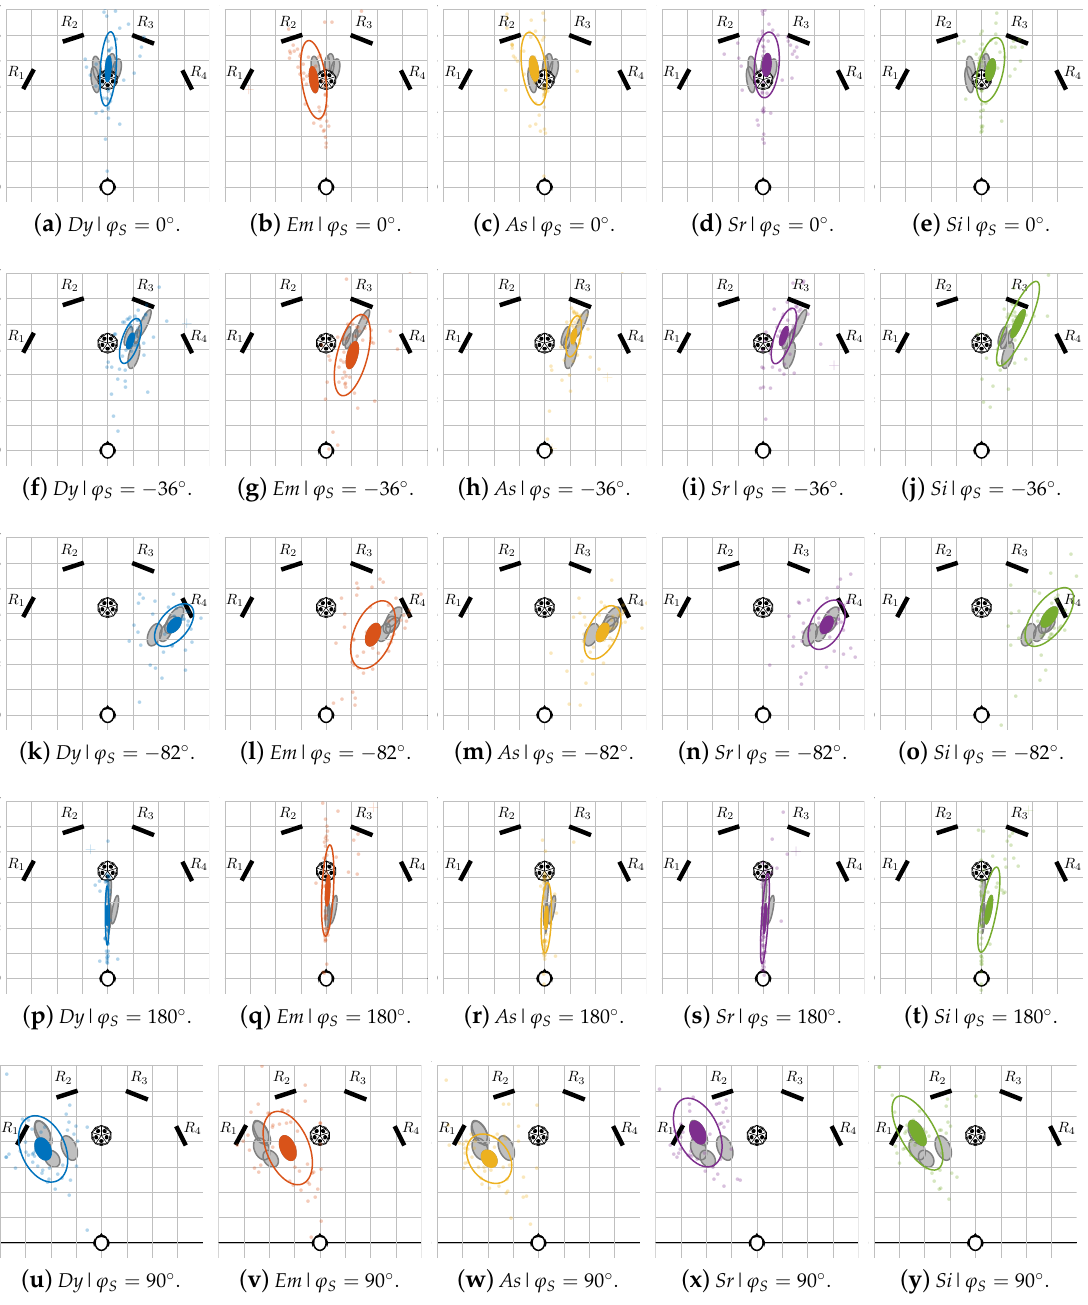
Figure 7. Bivariate statistical analysis of the perceived position of the auditory event per beam direction ϕ S (columns) and per auralization technique (rows). Data points, outliers, and standard deviation and 95% confidence region ellipses are indicated as dots, crosses, and not-filled and filled ellipses,